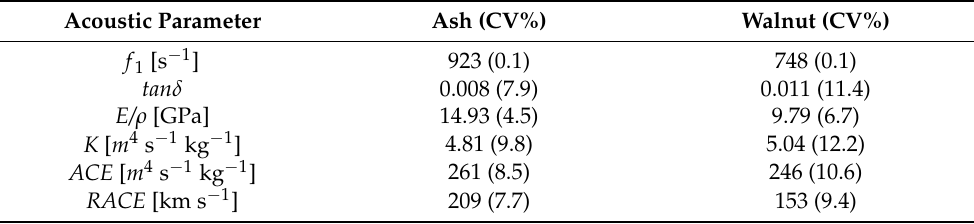
Table 1. Mean acoustic quality indicators of ash (A) and walnut (W) wood, determined by flexural vibration of elements for electric guitar solid body: f 1 —fundamental frequency, tan δ —vibration damping, E / ρ —specific modulus of elasticity, K —acoustic coefficient, ACE —acoustic conversion efficiency and RACE —relative acoustic conversion efficiency (CV%—Coefficient of variation)